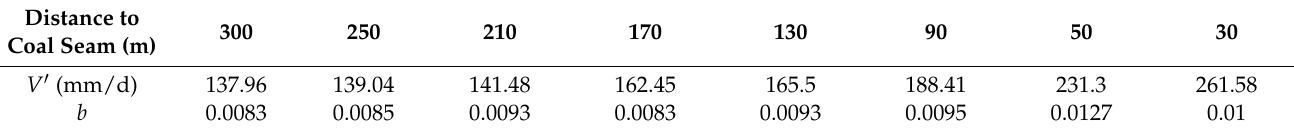
Table 2. The MSV parameter of the overlying